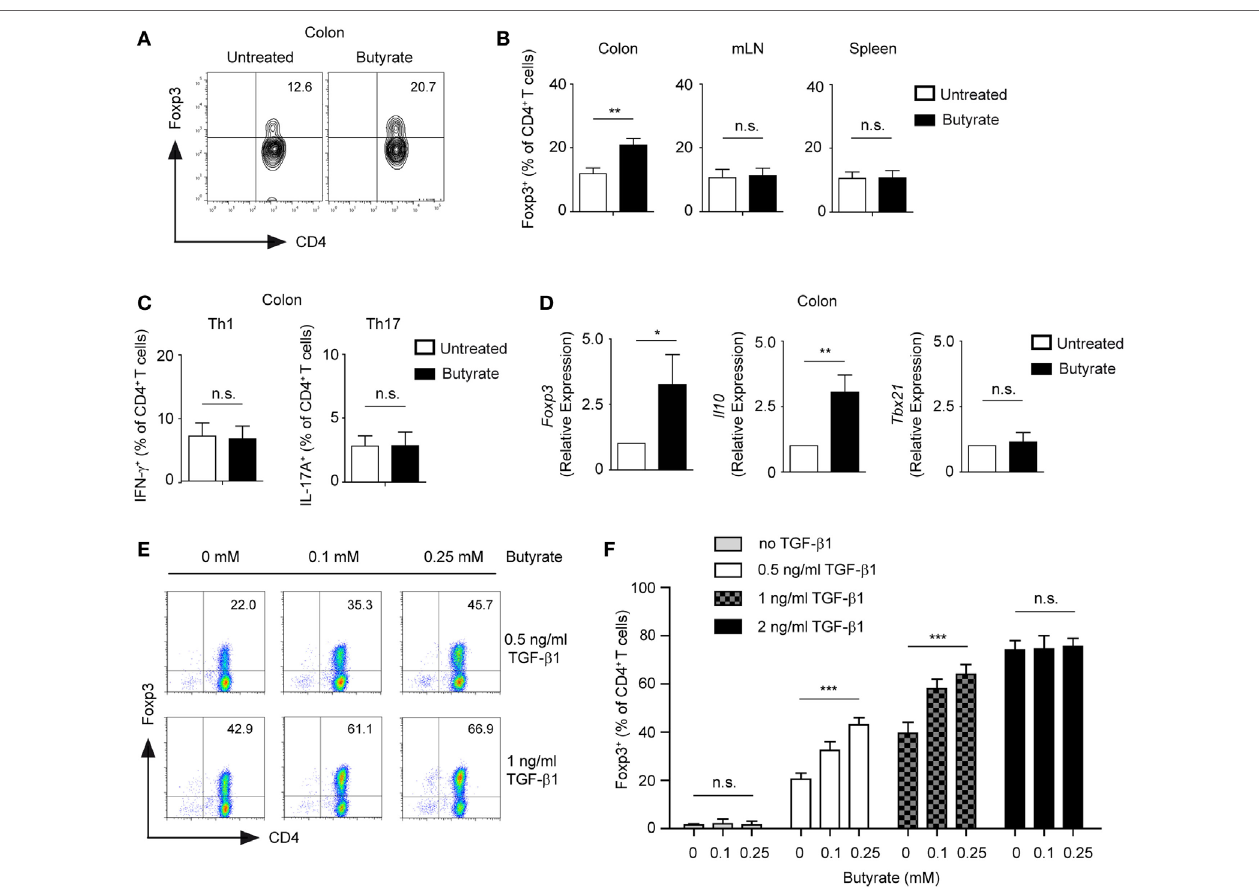
FigUre 1 | Butyrate promotes the expansion of Foxp3 + regulatory T cells (Tregs). (a,B) Wild-type (WT) mice were orally treated with 100 mM sodium butyrate for 3 weeks. The frequency of Foxp3 + Tregs was measured in colonic lamina propria, mesenteric lymph nodes, and spleen by FACS analysis. Bars represent mean ± SEM of two independent experiments; ** P = 0.001–0.01, n.s., not significant. (c) The percentage of Th1 and Th17 cells within colonic CD4 + T lymphocytes was analyzed after 3 weeks of oral treatment of WT mice with 100 mM sodium butyrate. Data are shown as mean ± SEM; n.s., not significant. Two experiments were performed. (D) The relative expression of Foxp3 , Il10 , and Tbx21 was analyzed by qRT-PCR in the colonic tissue of WT mice after oral treatment with butyrate (3 weeks, 100 mM sodium butyrate). Two similar experiments were performed. Data are the mean ± SEM; * P = 0.01–0.05, ** P = 0.001–0.01, and n.s., not significant. (e,F) CD4 + T cells were cultured under Treg-inducing conditions in the presence of indicated concentrations of sodium butyrate and TGF- β 1 for 5 days. Bars represent the mean ± SEM of three independent experiments; *** indicates P < 0.001, n.s., not